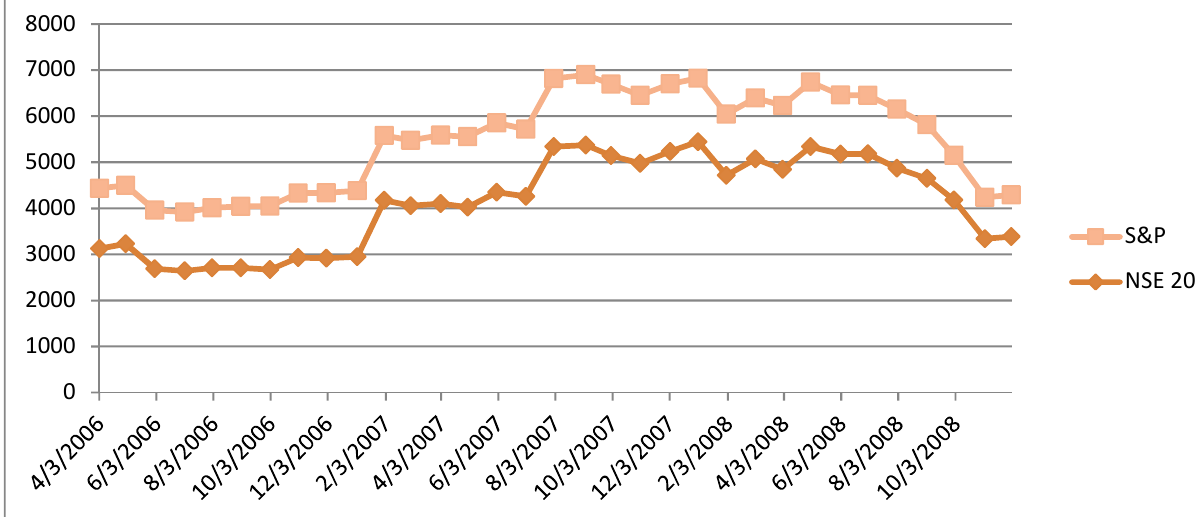
Fig. 6. Pre and post crisis Influence of the performance of NSE 20 Share Index on Standard and poor’s Index